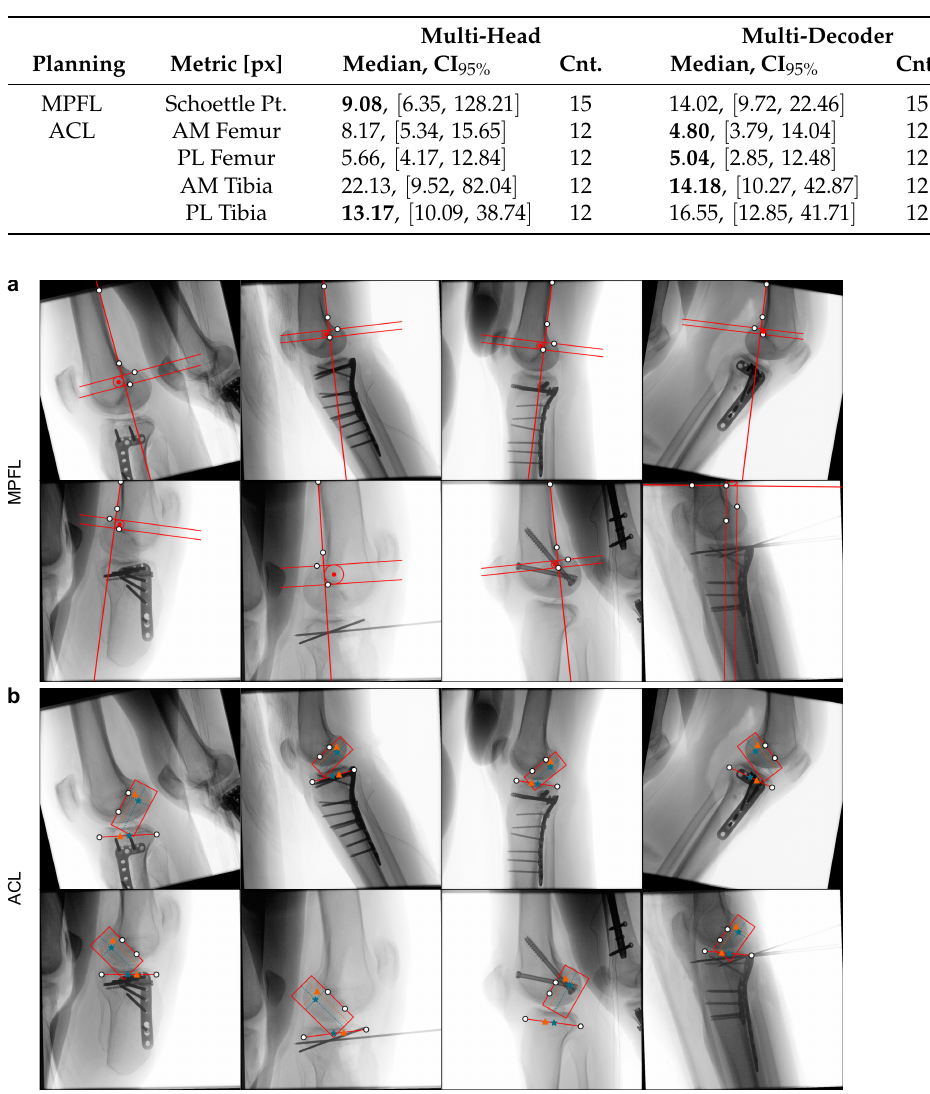
Figure 9. Planning predictions on intra-operative test data with multi-head topology and GradNorm task weighting. ( a ), MPFL. ( b ),